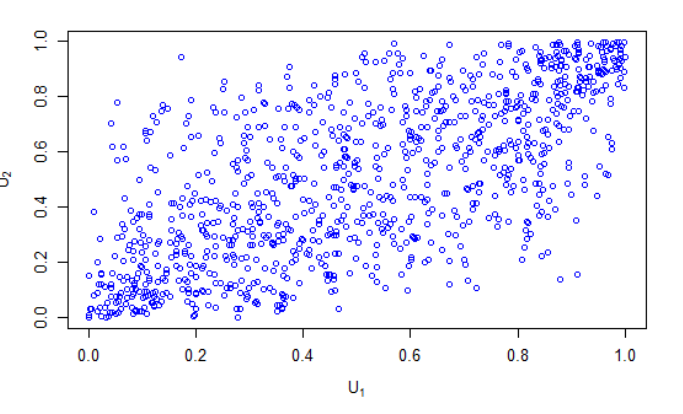
Figure 9. Gaussian distribution, Tau =